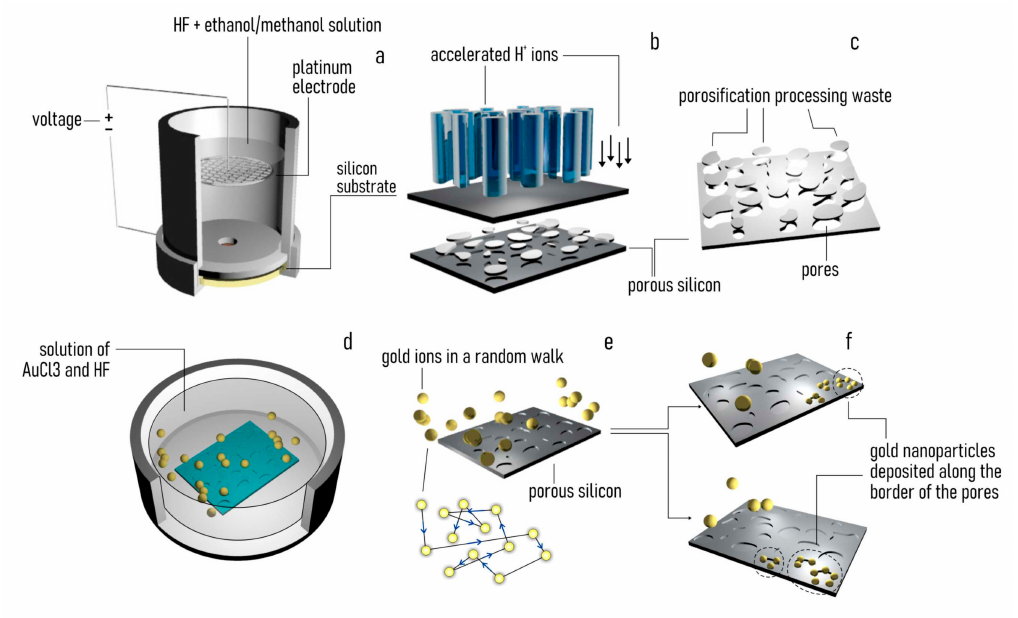
Figure 1. ( a ) An initial silicon chip of approximately 1 × 1 cm is electrochemical etched using a Teflon cell containing a solution of hydrofluoric acid (HF), D.I. (de-ionized) water, and methanol / ethanol in di ff erent ratios. ( b ) Upon activation of an external controlled voltage, positive ions in solution are accelerated towards the silicon substrate, creating pores within its structure. ( c ) Depending on the parameters of the process, including etching time, current and voltage intensity, and the concentration of the reagents in solution, one can obtain porous silicon surfaces with a tailored morphology. ( d ) The porous silicon sample is then placed in a baker along with a solution of hydrofluoric acid (HF) and gold(III) chloride (AuCl 3 ). ( e ) The resulting electroless process enables the deposition of gold ions in solution on the autocatalytic porous-silicon surface. ( f ) By varying the parameters of the electroless process, including temperature, concentration, and time, one can produce substrates with controlled gold-nanoparticles shape, size, and